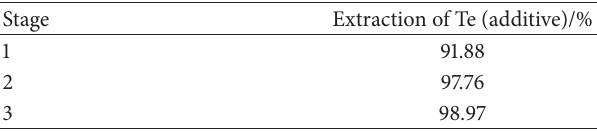
Table 6: Effect of repeated extraction on Te(IV)